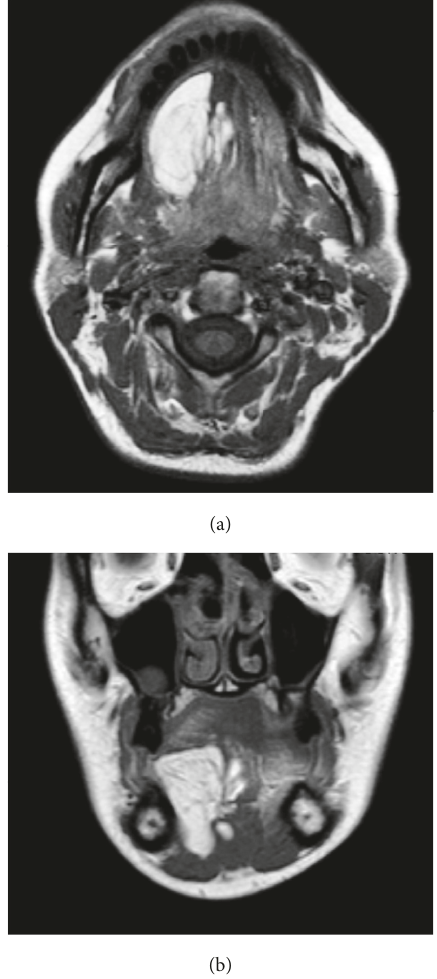
Figure 2: Axial (a) and coronal (b) MRI of the lesion (see text for